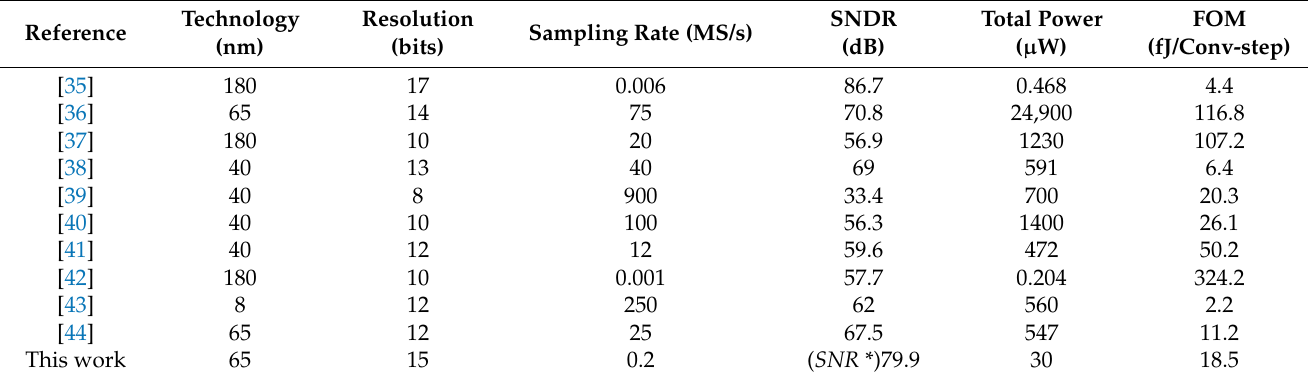
Table 2. ADC performance summary and